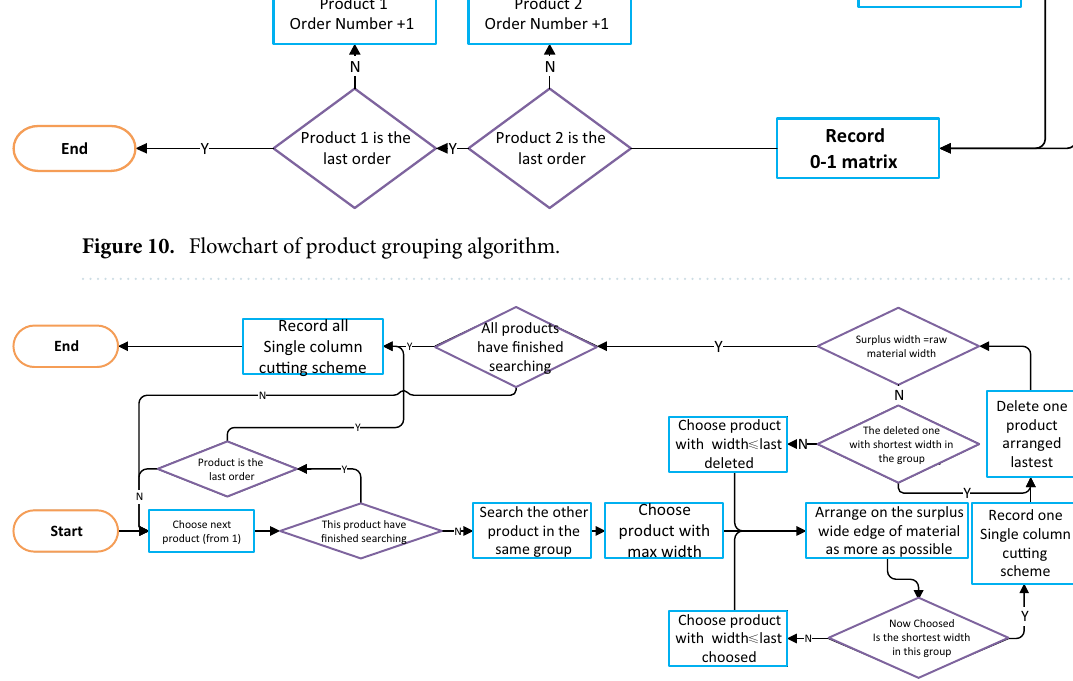
Figure 11. Flowchart of single column cutting scheme searching algorithm.